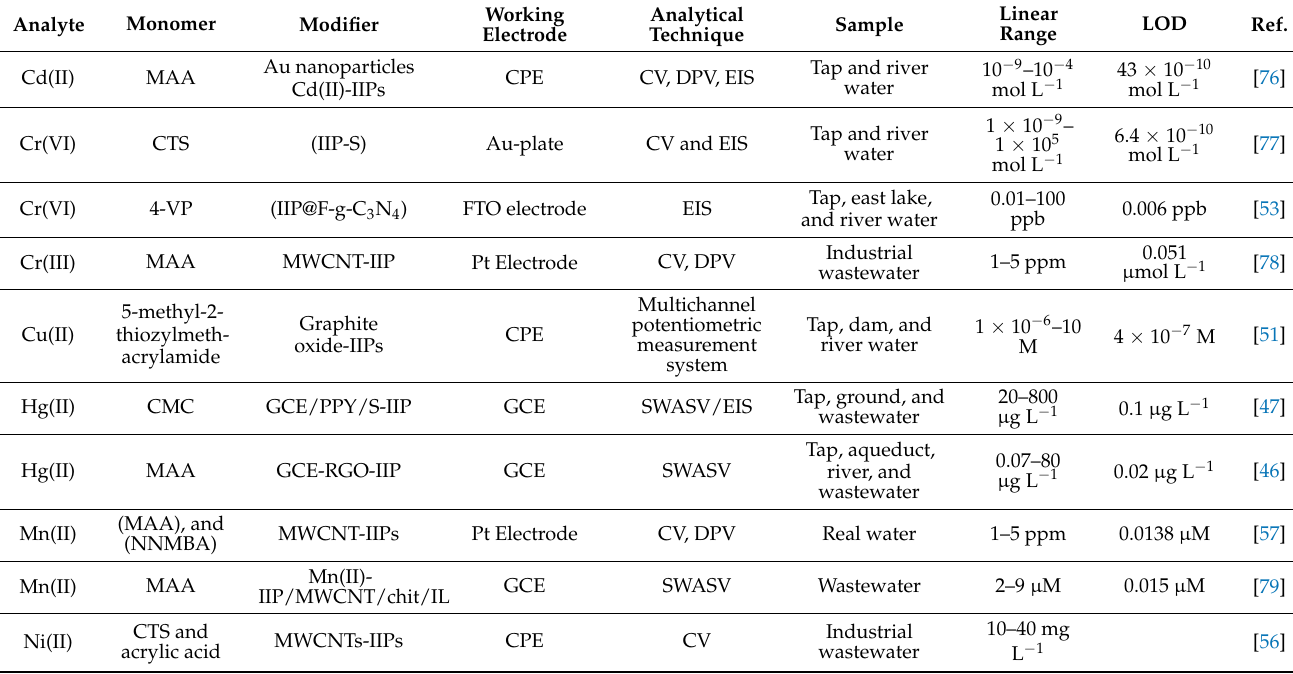
Table 2. Determinations of heavy metal ions using voltammetric sensors modified with